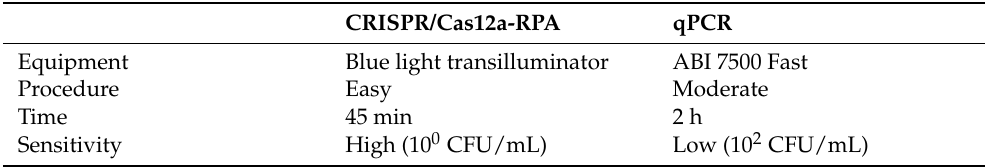
Figure 5. Detection of pathogenic Y. enterocolitica in pork matrix using the CRISPR/Cas12a-RPA system and comparison with qPCR: ( a ) CRISPR system curves from raw pork infected with different concentrations of pathogenic Y. enterocolitica ; ( b ) endpoint fluorescence and visualization from the infected pork; ( c ) CRISPR system standard curves for the detection of pathogenic Y. enterocolitica in the raw pork; ( d ) standard curves for pathogenic Y. enterocolitica detection based on qPCR C t values. N = 3 biological replicates, * p < 0.05, ** p < 0.01, *** p < 0.001, and **** p < 0.0001, NTC—non-target control; error bars represent mean ± SD. Table 2. Comparison between CRISPR/Cas12a-RPA and Standard